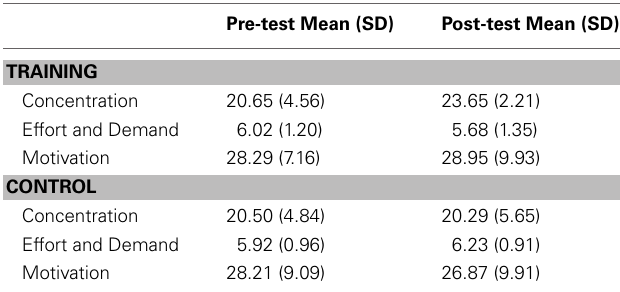
Table 3 | Means and standard deviations for self-reported task